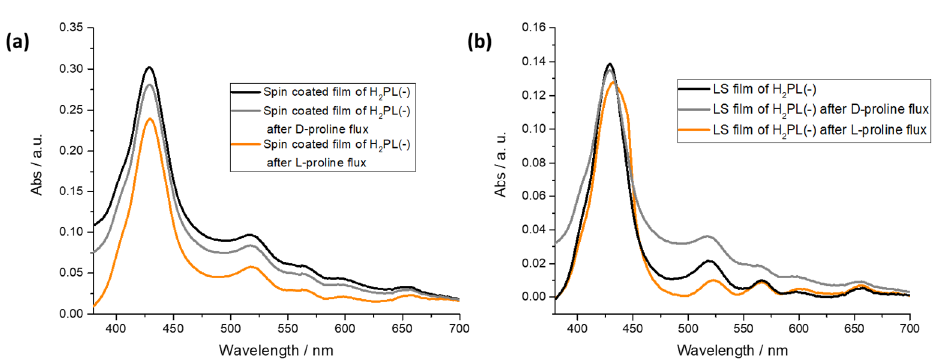
Figure 4. Effect of D- and L-proline flux on H 2 PL(-) spin-coated film ( a ) and H 2 PL(-) LS film from water subphase ( b ).